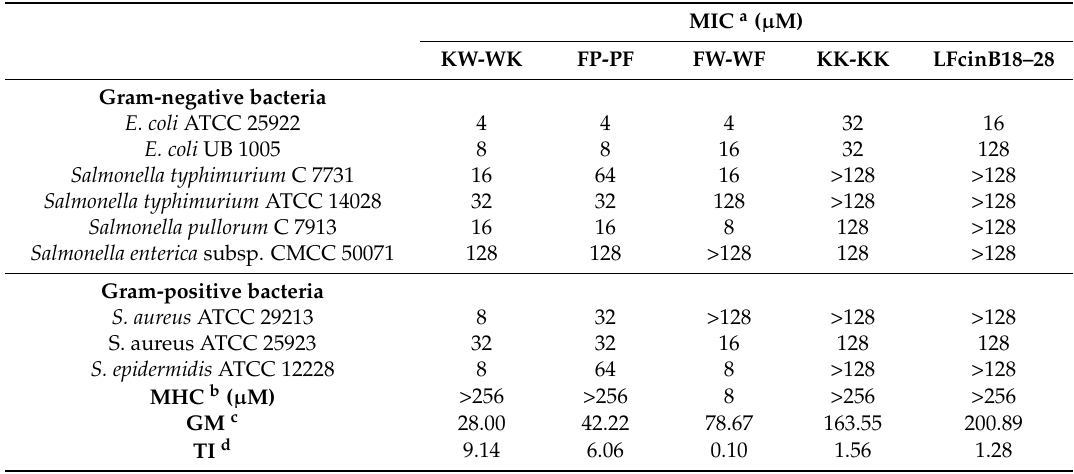
Table 2. Antimicrobial and hemolytic activities of the